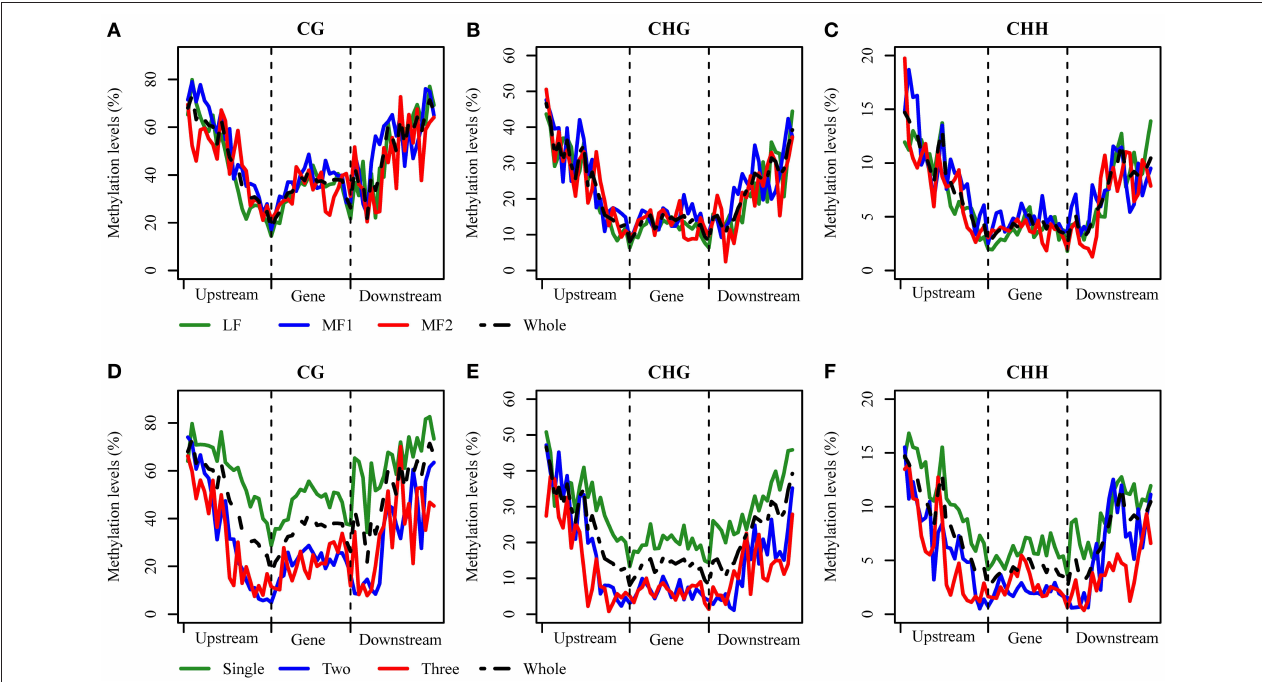
FIGURE 4 | DNA methylation distributed across genic regions at base-pair resolution. (A–C) between three subgenomes for CG, CHG, and CHH context and (D–F) between different copy genes for CG, CHG, and CHH